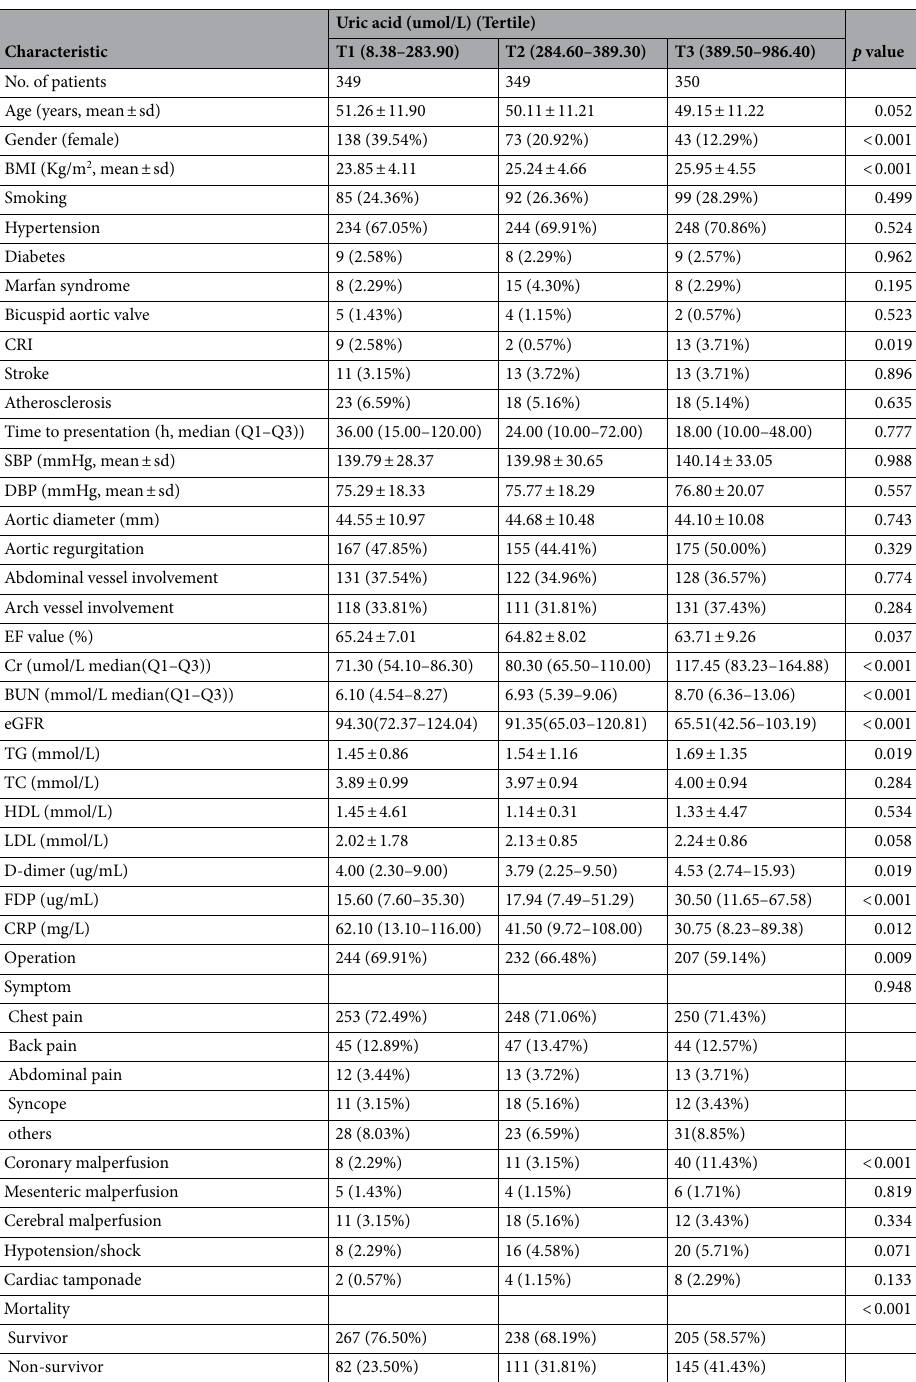
Table 1. Basline characteristics of the patients (N = 1048). BMI body mass index, SBP systolic blood pressure, DBP diastole blood pressure, Cr creatinine, BUN blood urea nitrogen, eGFR estimated glomerular filtration rate, TG triglyceride, TC total cholesterol, HDL high-density lipoprotein, LDL low-density lipoprotein, FDP fibrinogen and fibrin degradation products, CRP C-reactive protein, CRI chronic renal insufficiency, EF ejection